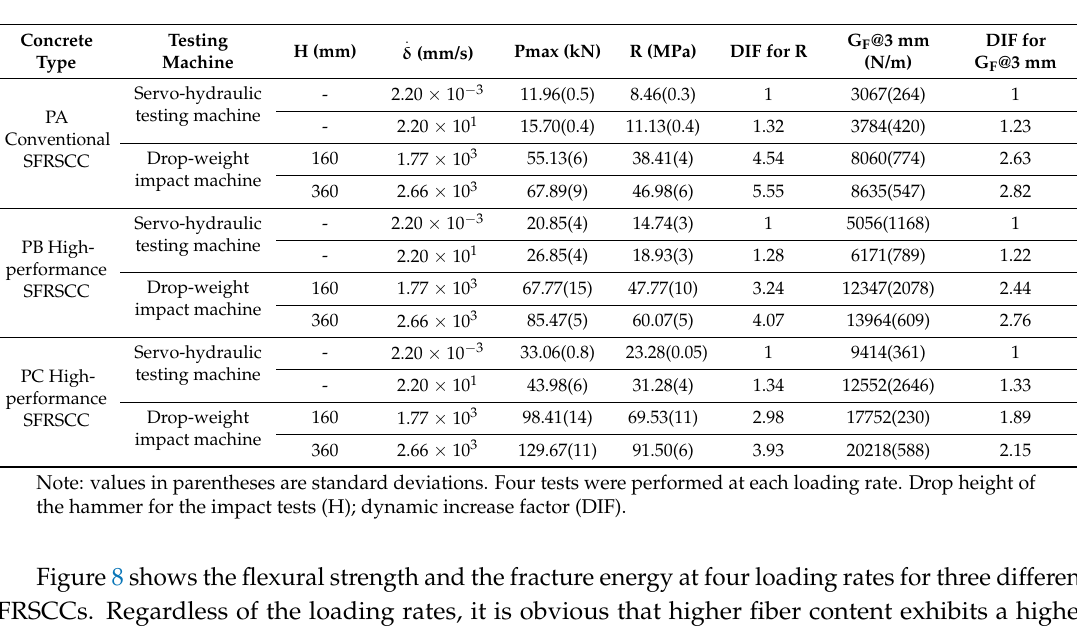
Table 4. Experimental results at different loading rates.